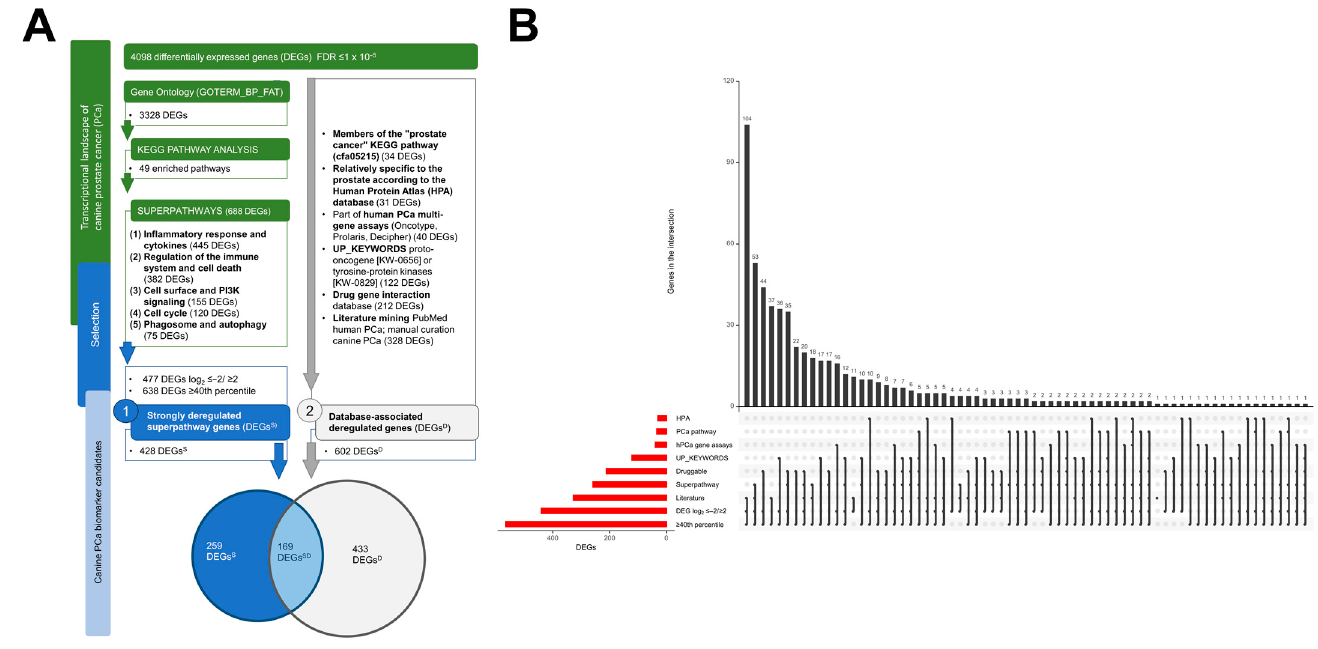
Figure 4. Intersections and selection of canine prostate cancer (PCa) biomarker candidates. ( A ) Flowchart indicating how selection of canine PCa biomarker candidates is performed based on two different approaches: (1) strongly deregulated superpathway genes (DEGs S ) and (2) database-associated deregulated genes (DEGs D ), with overlap DEGs SD . FNA: Fine- needle aspiration sample; KEGG: Kyoto Encyclopedia of Genes and Genomes; REVIGO: Reduce + Visualize Gene ontology; ( B ) V UpSet plot visualizing the intersection between different groups of differentially expressed genes (DEGs) according to the two different approaches. Criteria for DEGs D : the human protein atlas (HPA) database, the “prostate cancer” pathway of the Kyoto encyclopedia of genes and genomes (PCa pathway), human prostate cancer multi-gene assays (hPCa gene assays), UniProt keywords proto-oncogene [KW-0656] and tyrosine-protein kinases [KW-0829] (UP_KEYWORDS), druggable database and literature. Criteria for DEGs S : superpathway, strongly DEGs with base-2 logarithm (log 2 ) fold- change ≤− 2/ ≥ 2 and ≥ 40th percentile. Intersections of DEG S and DEGs D as selection criteria for DEGs SD . The horizontal bars (left, red) display the total number of DEGs in each group. The vertical bars (top, gray) visualize the number of DEGs in each combination of groups, as indicated by the dots. Note that all the intersections are disjoint.